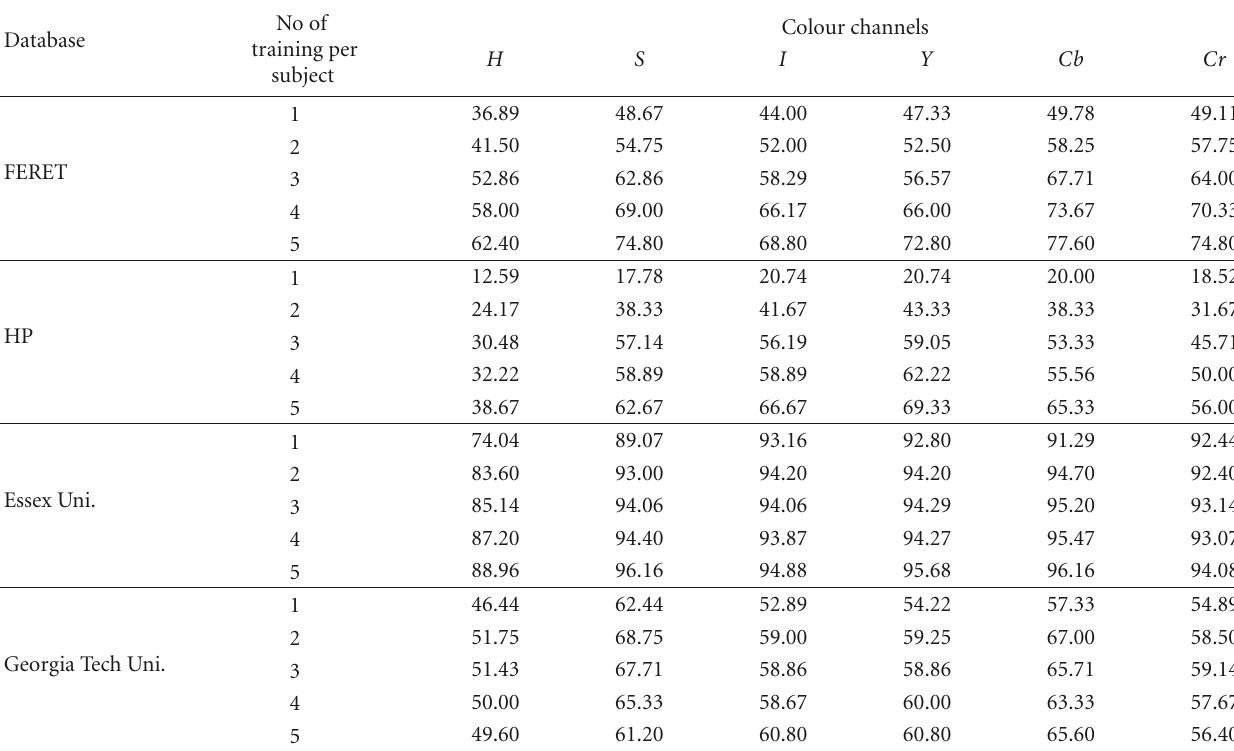
Table 3: Performance of the PCA-based system in H, S, I, Y, Cb, and Cr colour channels of di ff erent face databases. Database